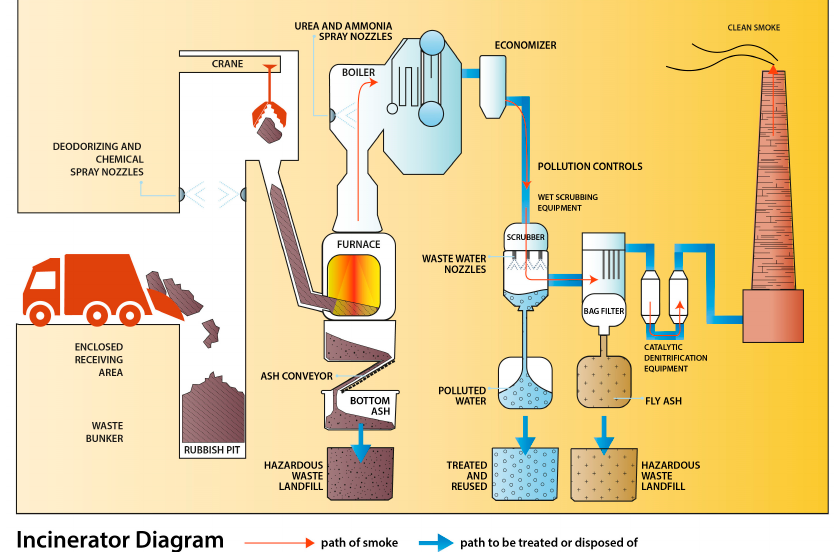
Figure 4. Scheme of pollution control from MSW incineration plants.